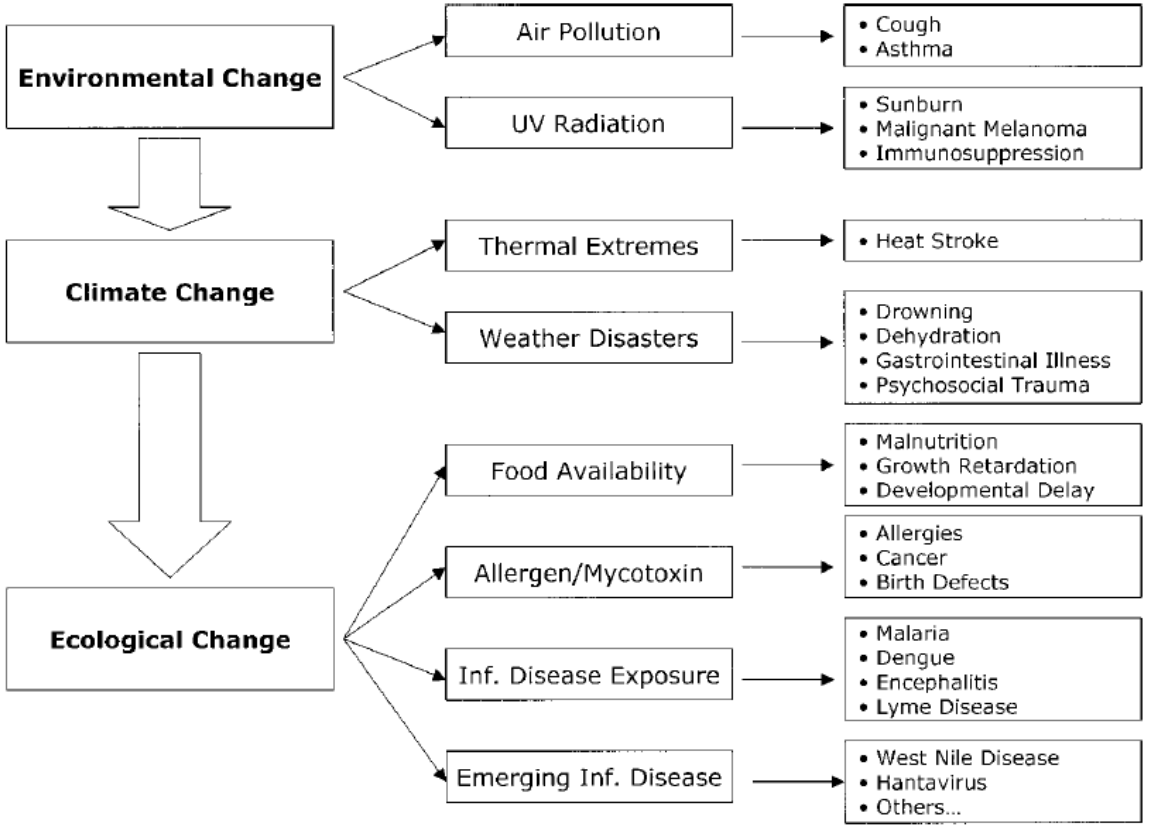
Figure 3. The relationship between environmental change, climate change, ecologic change, and child health